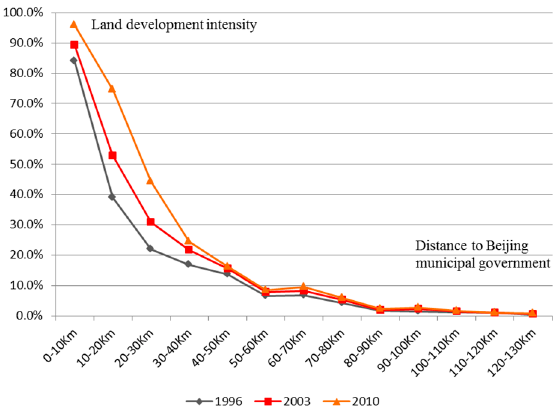
Figure 6. The land development intensity in buffer rings around the municipal government in Beijing.